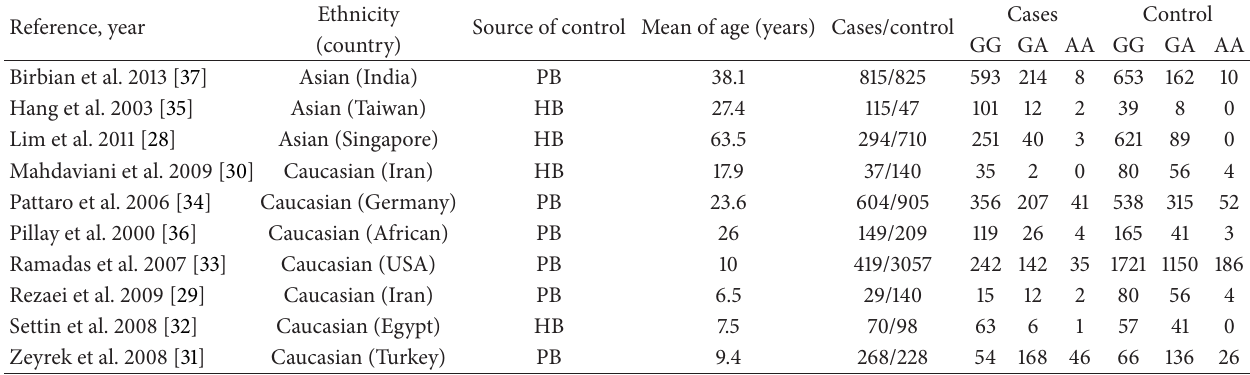
Table 2: Main data of all studies included in the meta-analysis for the polymorphism in IL-1RA